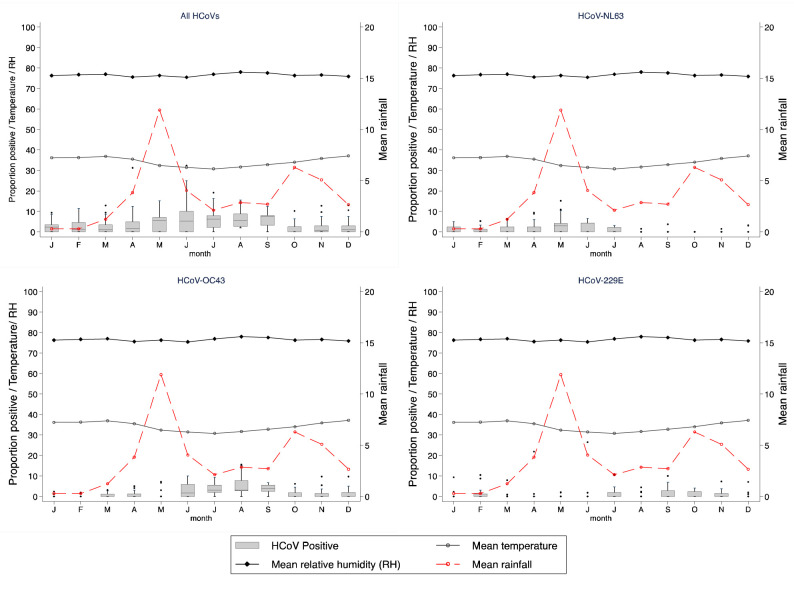
Proportion of monthly positive cases observed at Kilifi County Hospital, Kilifi, Kenya by HCoV type over a period of 13 years (2007–2019).The primary y-axis denotes the proportion of samples positive for HCoV the average monthly maximum temperature in °C and relative humidity (%) while the secondary y-axis denotes the average monthly rainfall in millimetres.